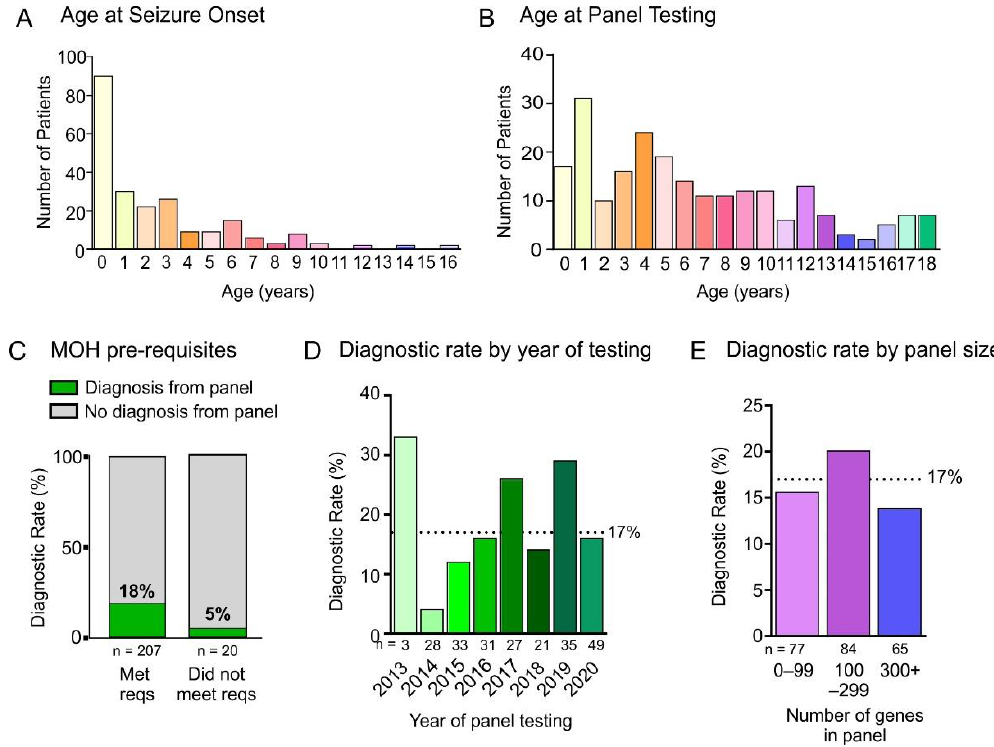
Figure 5. Guidelines. ( A , B ) Age of patients at seizure onset ( A ) and age at panel testing ( B ) for the patients in the epilepsy panel cohort. ( C ) Diagnostic rate of patients who met the Ministry of Health of Ontario testing pre-requisite investigations of EEG and MRI compared to those who did not meet the requirement (no MRI head was carried out). ( D ) Diagnostic rate of epilepsy panel testing by year of testing compared to overall rate of 17% (dotted line). ( E ) Diagnostic rate of epilepsy panel testing based on number of genes in epilepsy